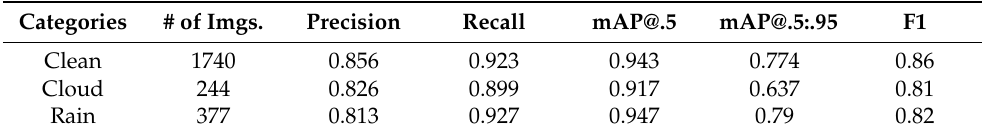
Table 4. Comparison of the recognition performance in different weather